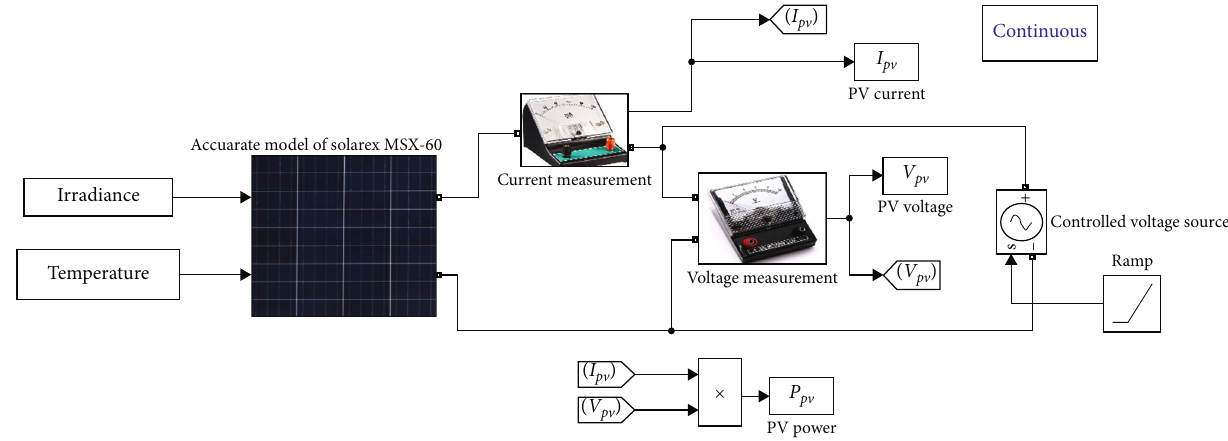
Figure 5: Data generation